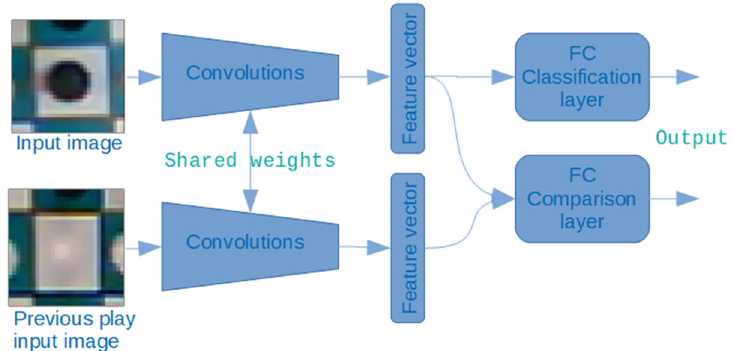
Figure 9. Structure of the Siamese network (FC: Fully Connected).